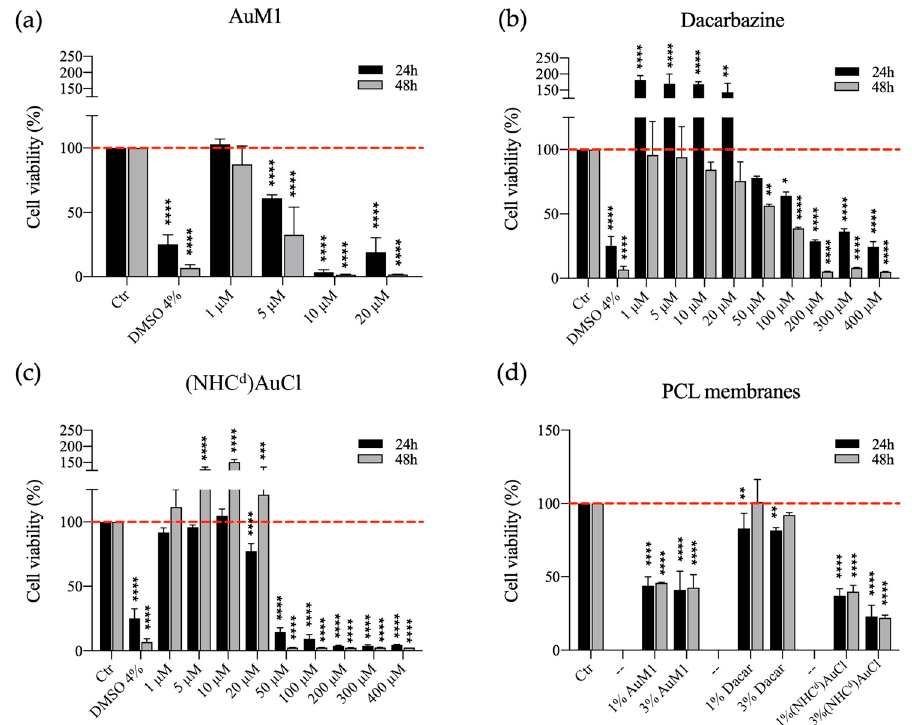
Figure 8. MTT assay on MeWo cells treated with free compounds or seeded on PCL functionalized membranes. 1, 5, 10, 20, 50, 100, 200, 300 and 400 µ M of AuM1 ( a ), Dacarbazine ( b ) and (NHC d )AuCl ( c ) were tested to evaluate the cytotoxic effect of free compounds on MeWo cells; MeWo viability was also studied seeding cells on PCL membranes ( d ), functionalized with 1% and 3% of each compound. The experiments were analyzed by ordinary one-way ANOVA test. * p ≤ 0.05, ** p < 0.01, *** p < 0.001, and **** p ≤ 0.0001 ( n = 3).